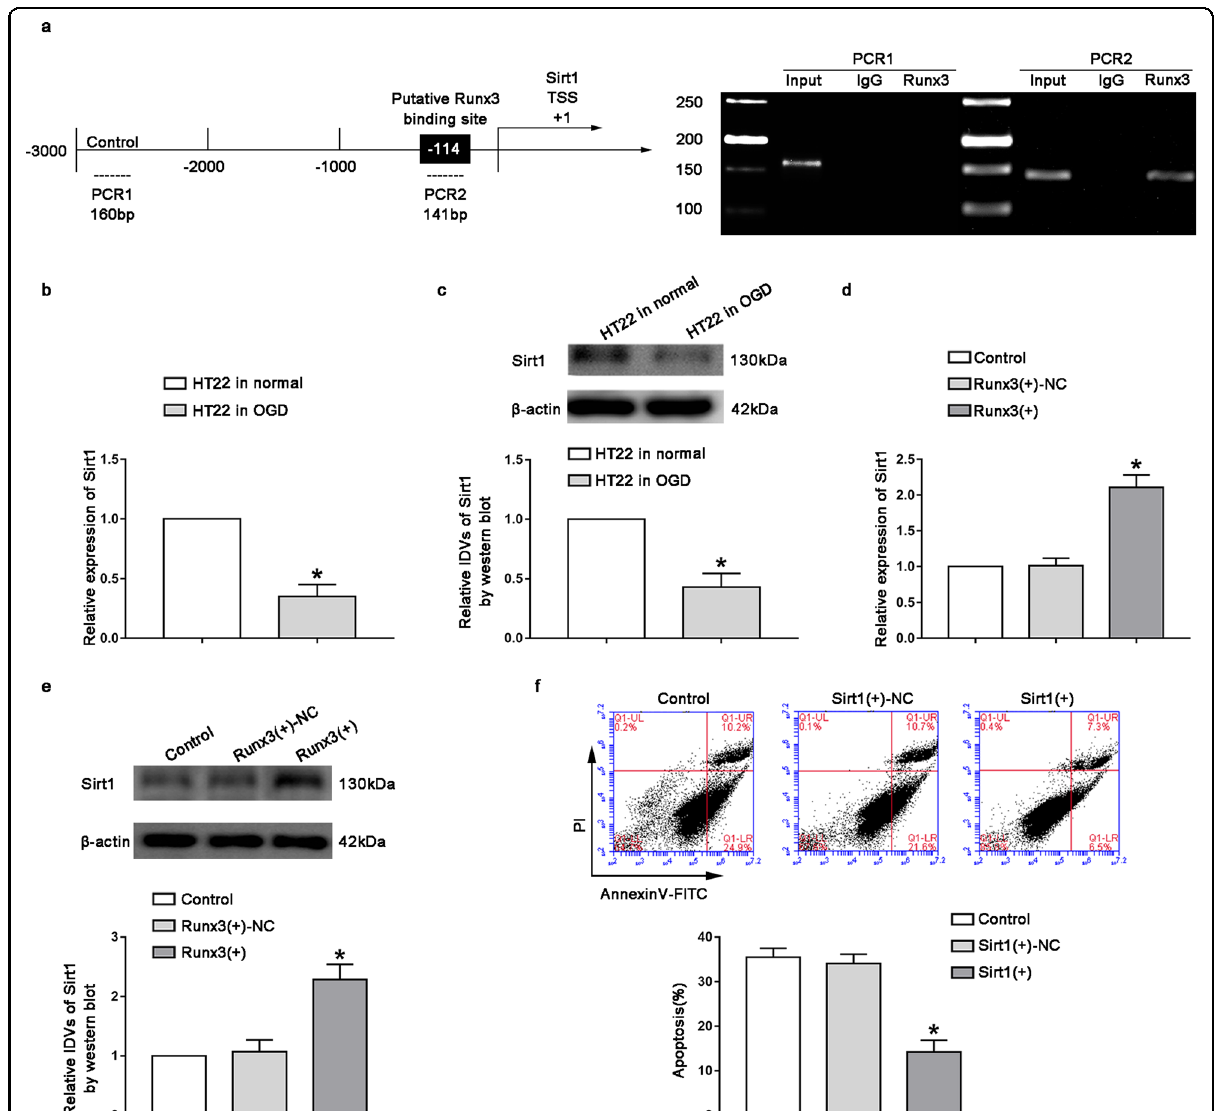
Fig. 4 Runx3 bound to the promoter regions of Sirt1, Sirt1 inhibited neuronal apoptosis by CCI. a Runx3 bound to the promoter of Sirt1 in HT22 cell lines. Immunoprecipitated DNA was ampli fi ed by PCR. b , c Relative expression levels of Sirt1 were measured by qRT-PCR and western blot. Data represented as mean ± SD. ( n = 3), * P < 0.05 vs. HT22 in normal group. d , e Relative expression levels of Sirt1 were measured by qRT-PCR and western blot after Runx3 overexpression Data represented as mean ± SD. ( n = 3), * P < 0.05 vs. Runx3( + )-NC group. f Flow cytometry analysis of OGD- induced HT22 cells after Sirt1 overexpression with annexin V/PI staining. Data represented as mean ± SD. ( n = 3, each group) * P < 0.05 vs. Sirt1 ( + )-NC